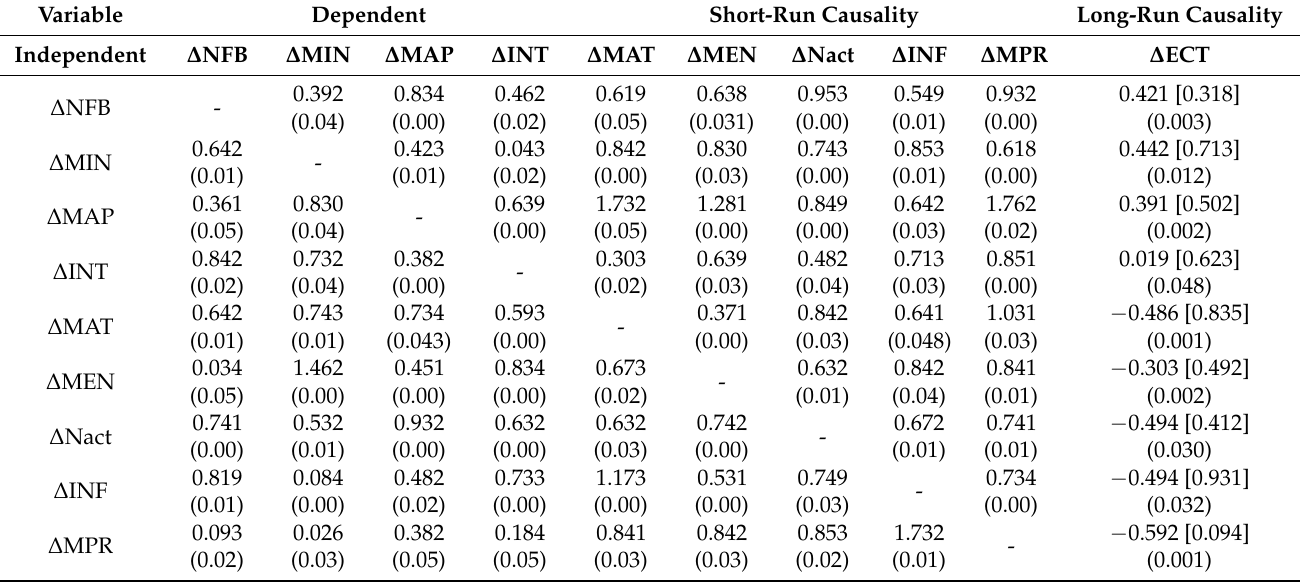
Table 7. VECM Granger causality analysis (Guangxi Zhuang Autonomous